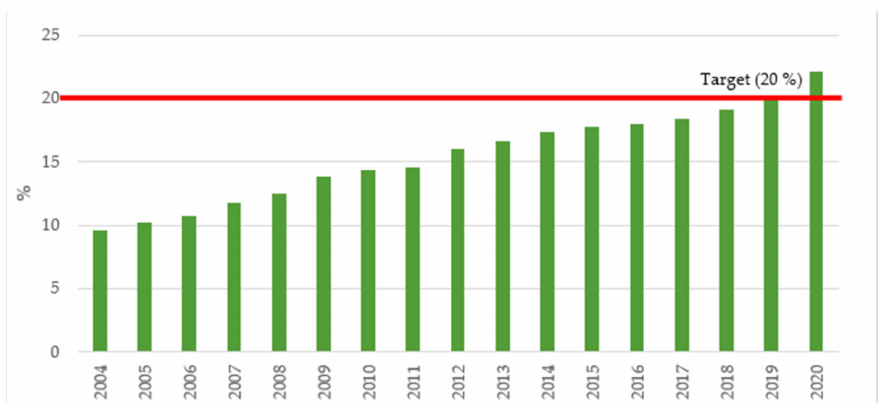
Figure 2. The share of RES and implementation of the target in the EU, 2004–2020. Source: [48].